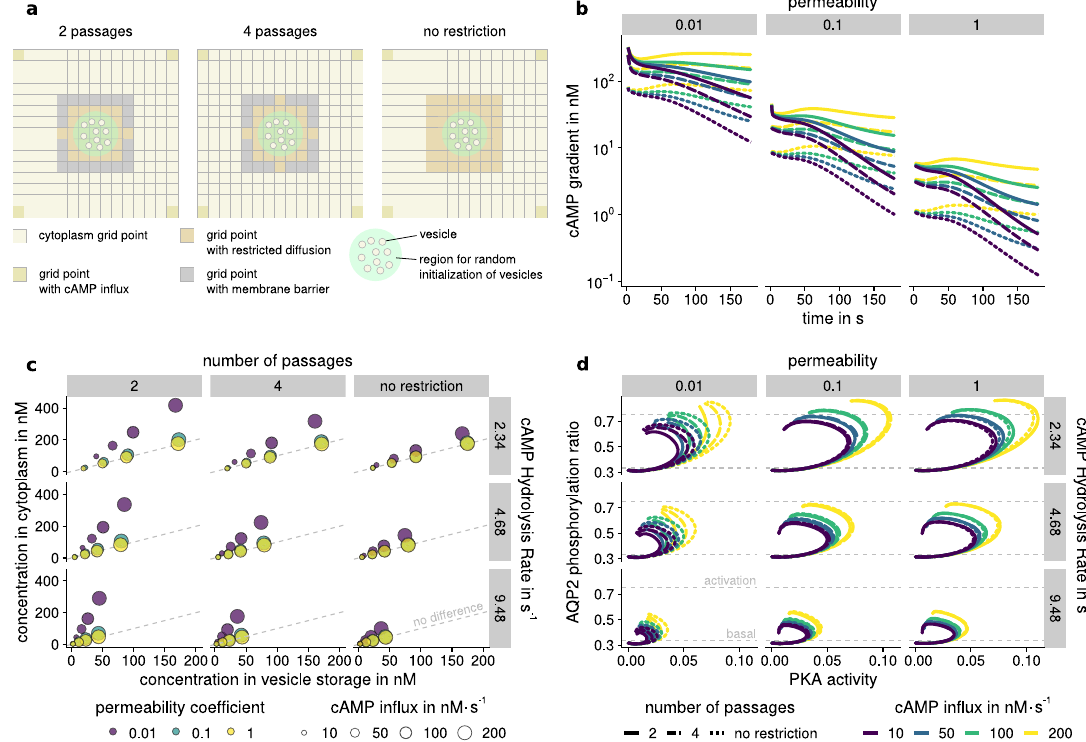
Fig. 4 cAMP compartmentalization in different environments. Simulation of cAMP diffusion was performed in different environments and with multiple parameter sets. a Schematic representation of restricted environmental setups with and without barriers around a vesicle storage region. b cAMP gradient over time, depending on the number of passages (dashed lines) and cAMP in fl ux (color). Simulations without permeability reduction (decrease in diffusivity) are unable to maintain effective gradients of 100 nM or more. c In fl uence of PDE4D hydrolysis rate and a number of passages on concentration in different compartments after fi ve minutes of simulation. Circle size indicates cAMP in fl ux, whereas color shows permeability. Only the combination of diffusive restriction and low permeability was able to create signi fi cant differences in concentration, indicated by circles far away from the dashed lines. d Shown is the AQP2 phosphorylation ratio and PKA activity development during simulation starting from basal value. After an initial increase, a negative feedback loop fi rst slows and subsequently decreases phosphorylation rates. High PDE4 hydrolysis rate (increasing from top to bottom) leads to lower cAMP concentration in the vesicle region, leading to lower activity. High cAMP in fl ux (yellow lines) allows overcoming the phosphorylation threshold of 0.75. Abbreviations: protein kinase A (PKA), aquaporin 2 (AQP2), phosphodiesterase 4D